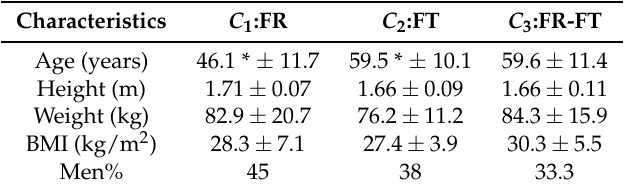
Table 1. Demographic characteristics of the data in the three classes (columns FR, FT, and FR-FT)